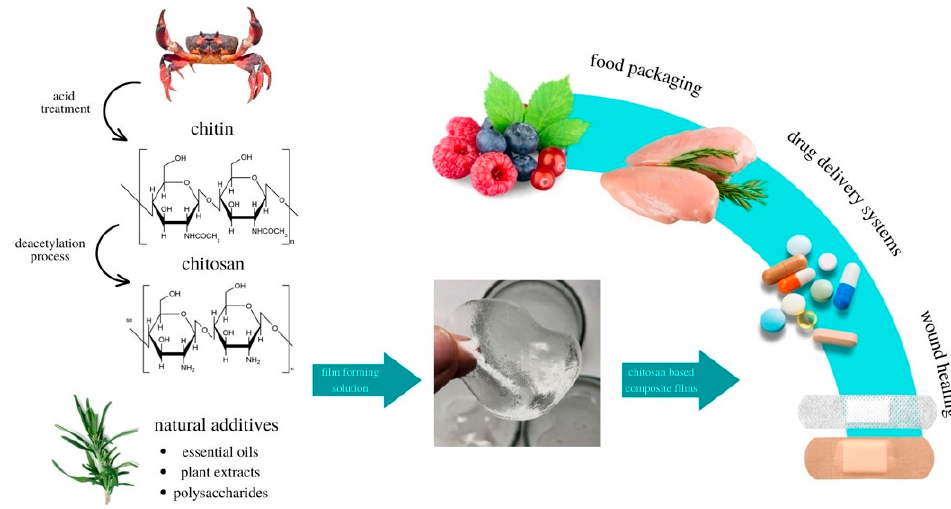
Figure 4. Usage of chitosan for film production and its potential applications.